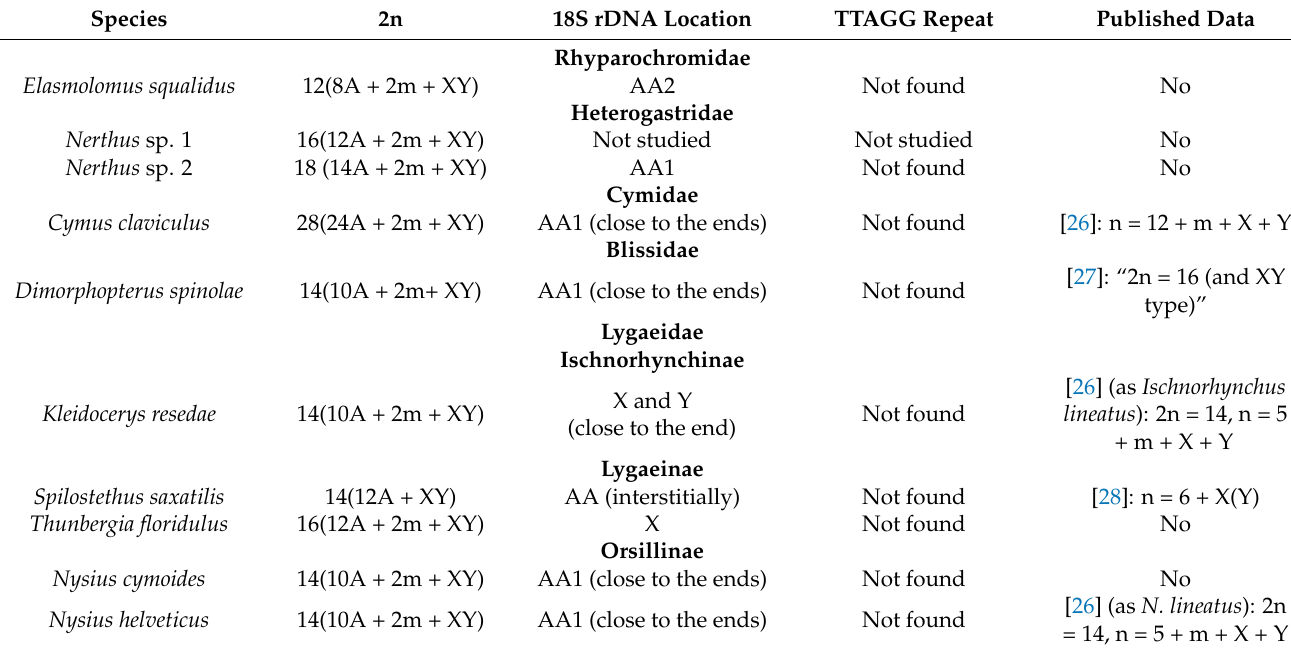
Table 2. Karyotypes of the studied species, with data on chromosome number and diploid karyotype formulae, rDNA loci location, TTAGG repeats, and references. A—autosome, AA—autosomal